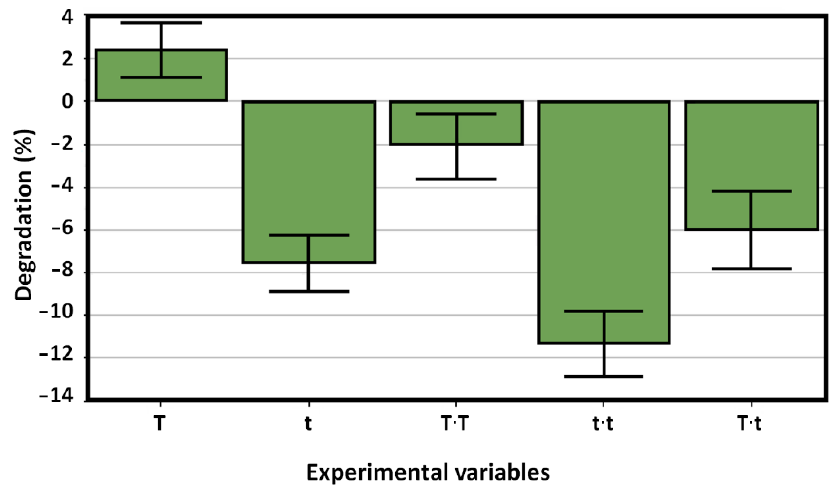
Figure 3. Statistical analysis of the polynomial response of the impact of temperature (T) and time (t) on the photocatalytic removal efficiency.